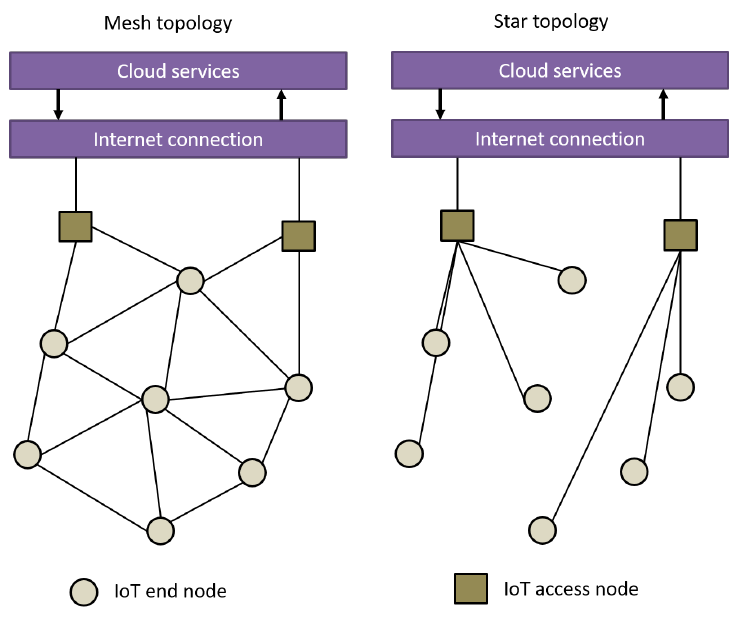
Figure 5. Comparison of a simplified IoT mesh and star network